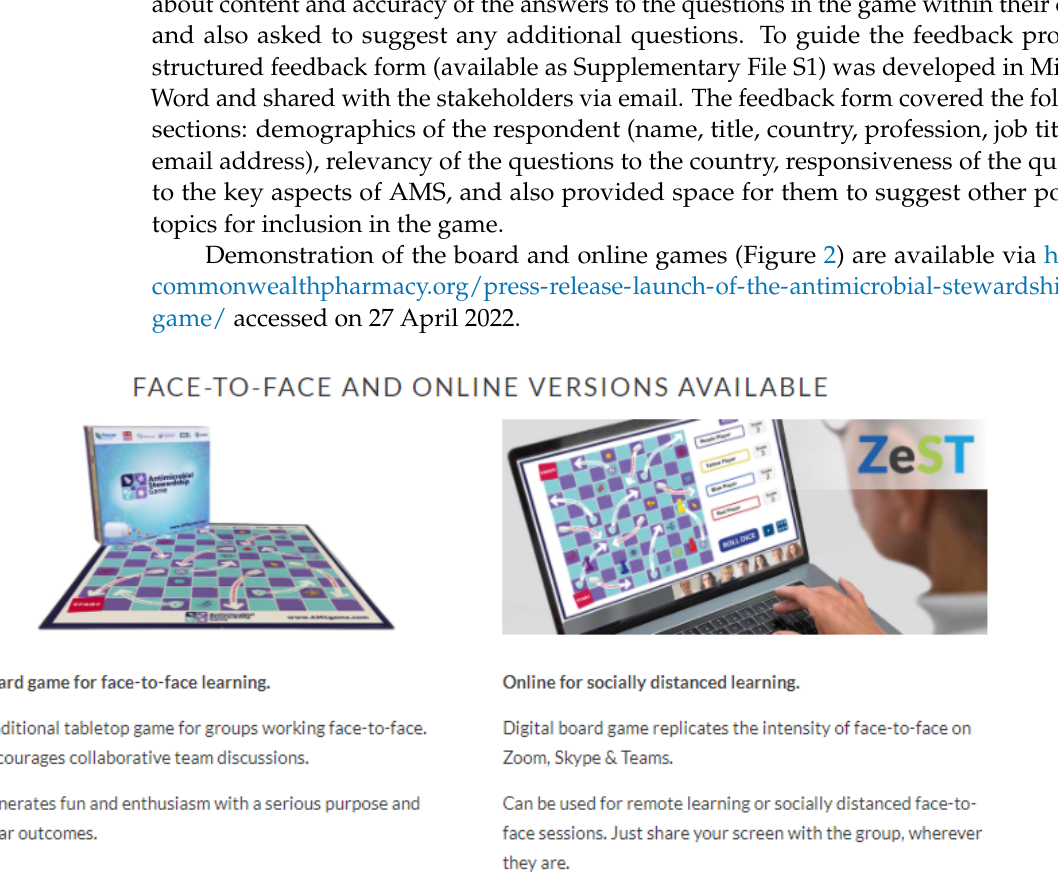
Figure 2. Board and online AMS games